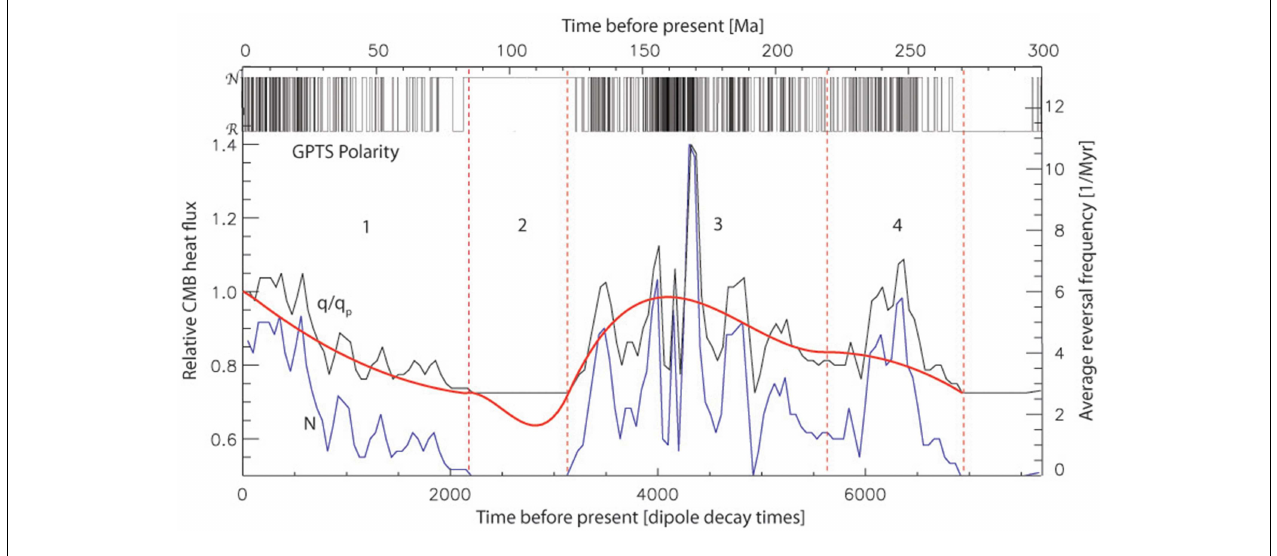
FIGURE 3 | CMB heat flux variations vs. time before present in Ma (top scale) and dipole decay times (bottom scale) derived from geomagnetic polarity reversal variations. Bar code shows 0–300Ma geomagneticpolarityrecordfromthe2012GPTS(Gradsteinetal.,2012). N is Normalgeomagneticpolarityand R isReversegeomagneticpolarity.Theblue